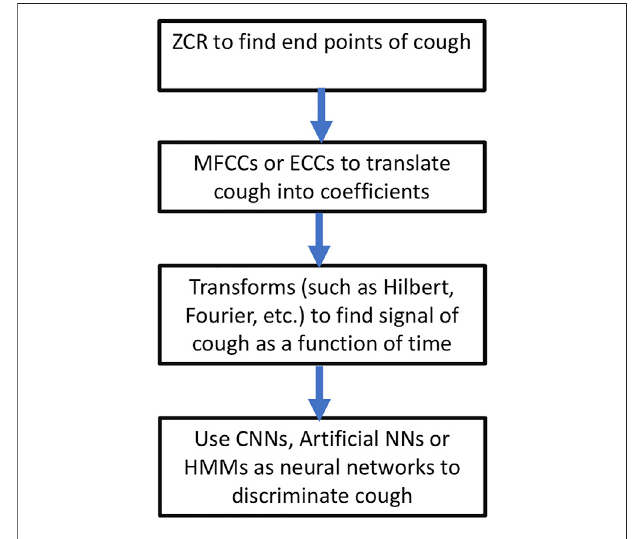
FIGURE 3 | Flowchart for Optimal Algorithm for Cough Discrimination, accord-ing to Amoh and Odame, 2016) and Shin et al. (2009) for COVID-19 would become, which is essential during a pandemic where millions are suffering across the